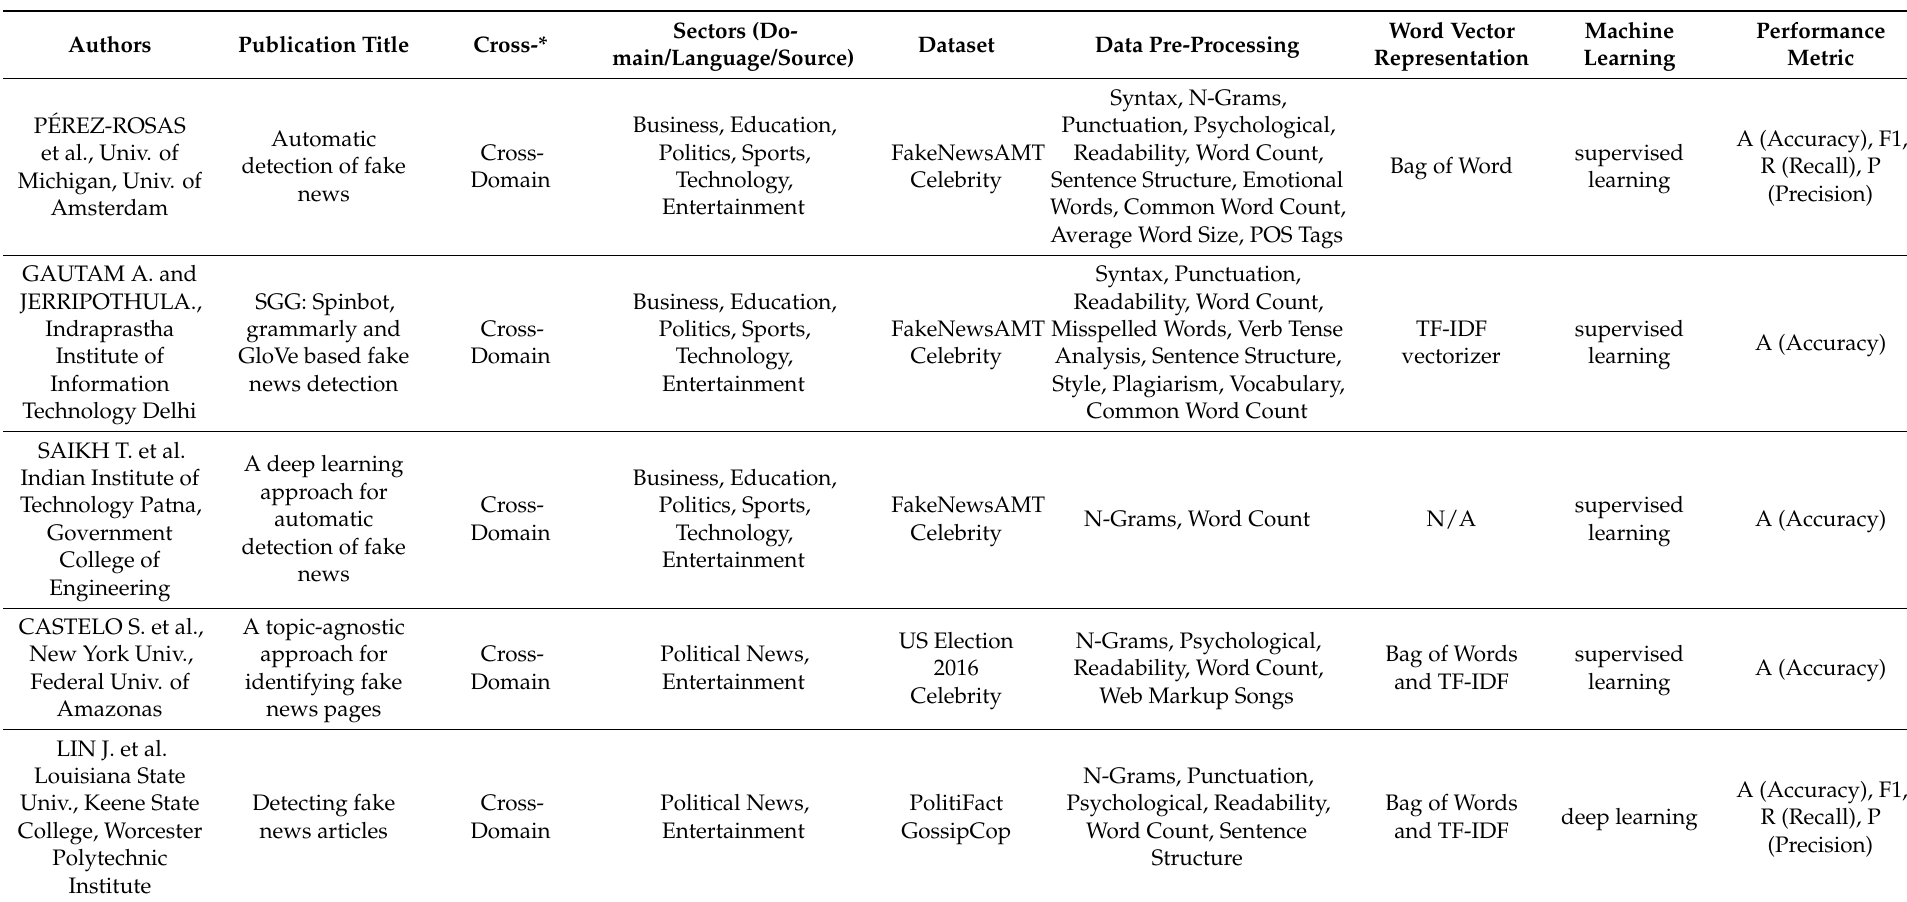
Table A1. A Thorough Comparison of Cross-* Misinformation Detection